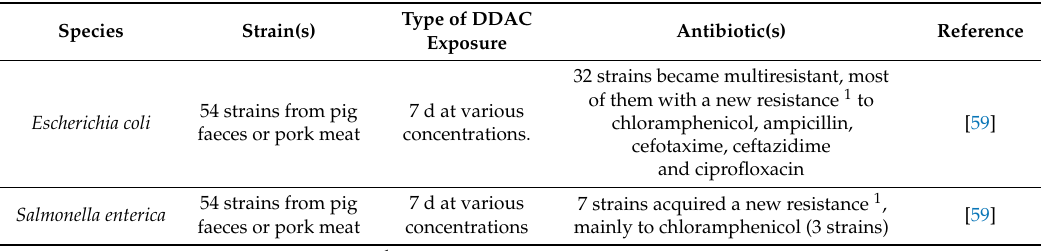
Table 5. Gram-negative species with antibiotic tolerance or resistance after low level exposure (< MIC value) to didecyldimethylammonium chloride